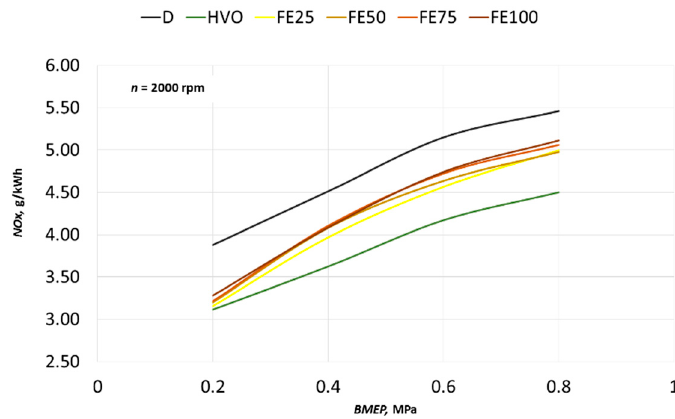
Figure 13. Dependence of nitrogen oxide emissions on the load.